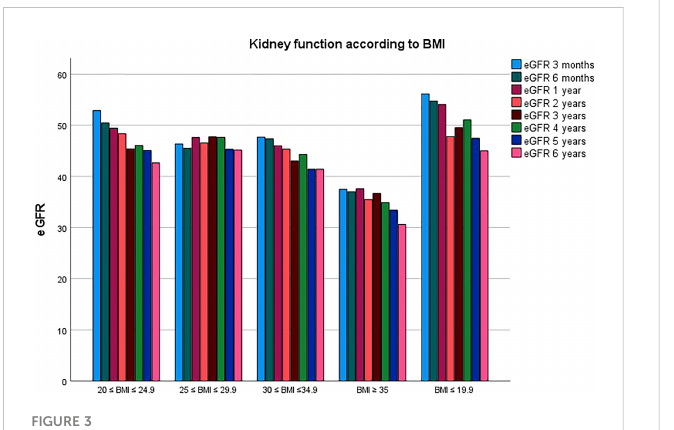
FIGURE 3 Comparison of kidney function between BMI classes.